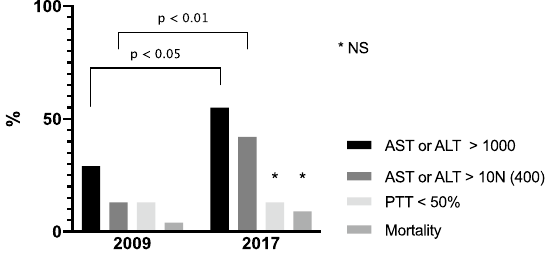
Fig. 1 Leukocyte genomic responses in patients admitted to the intensive care unit with a septic or non‑septic shock matched for severity upon admission